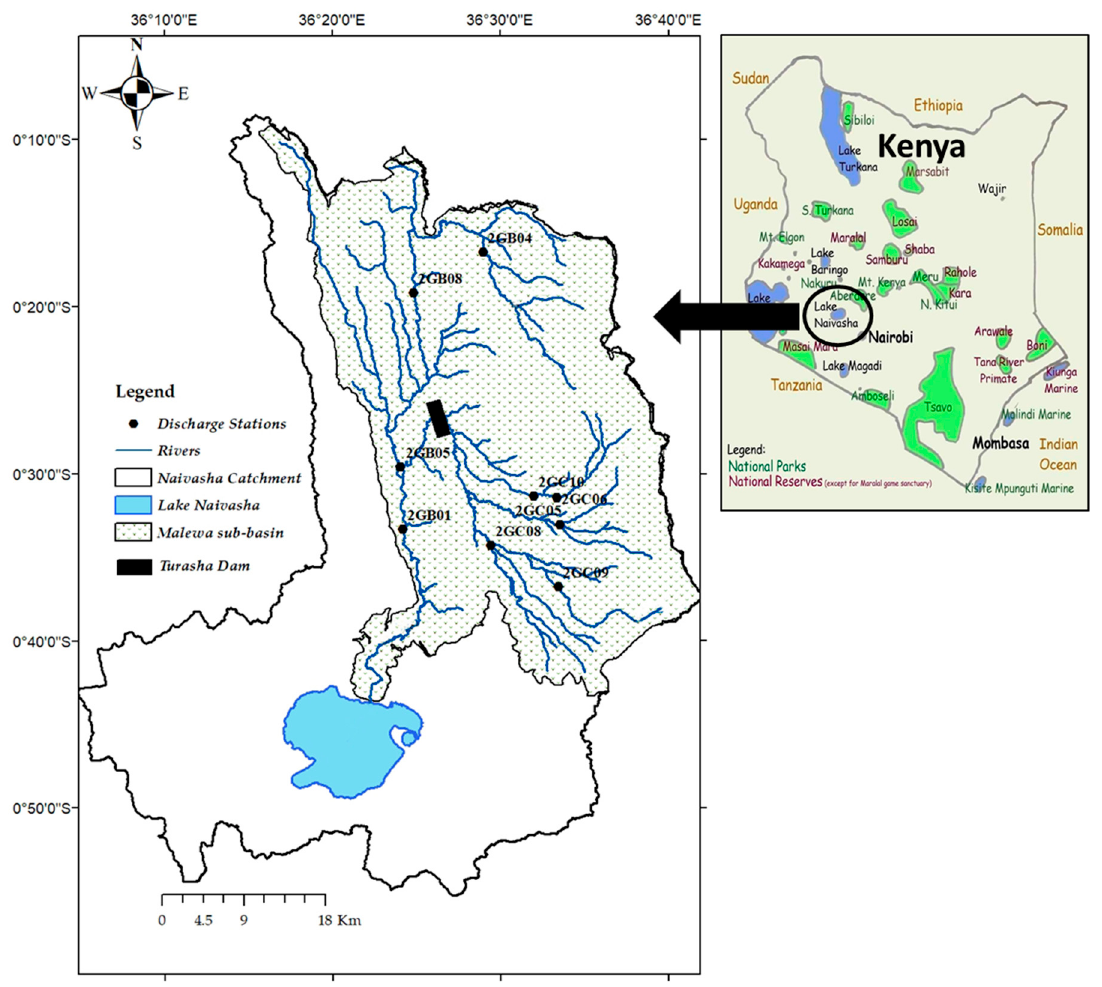
Figure 1. Study area map showing the location of Malewa River Basin and hydrological stations.